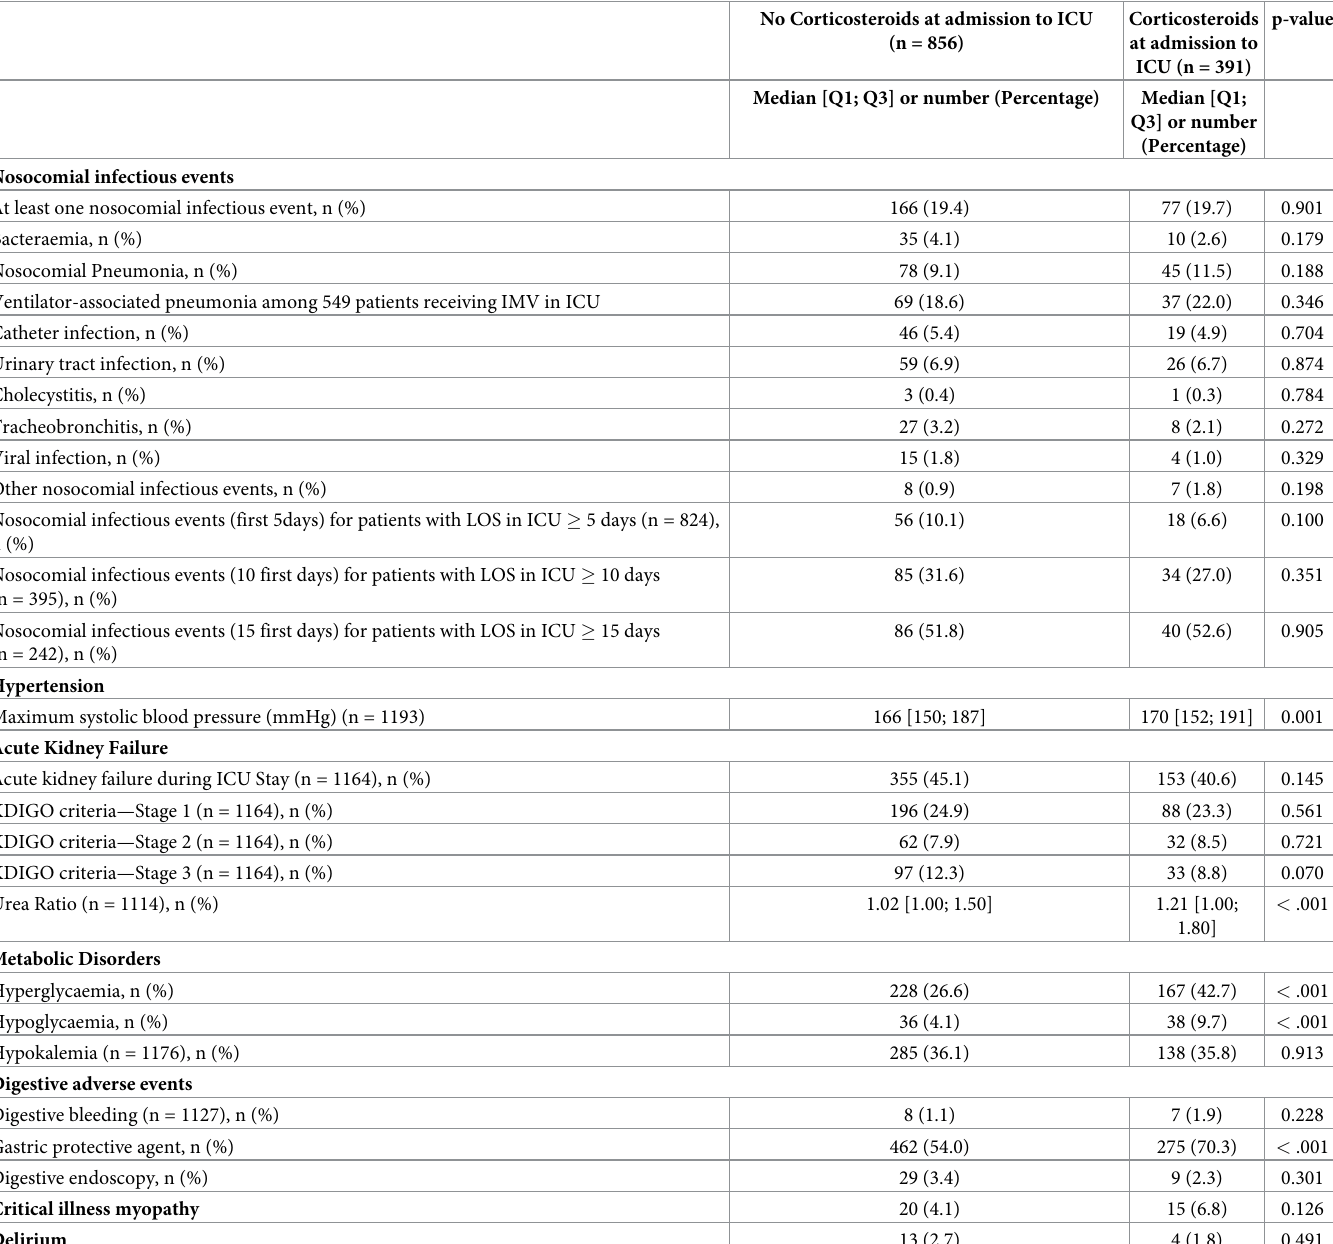
Table 3. Adverse events according to corticosteroids prescription for AECOPD at admission to ICU.